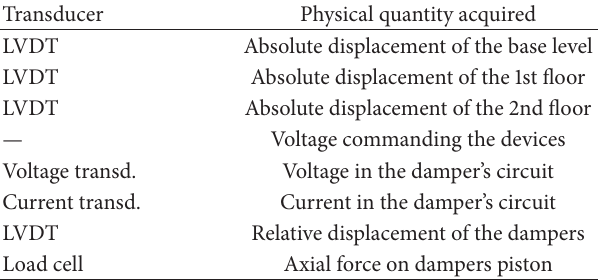
Table 2: Acquisition needed to the control activity.